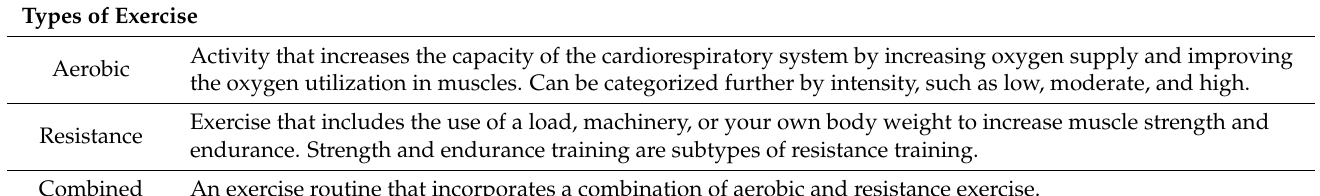
Table 2. Definitions of the different types of